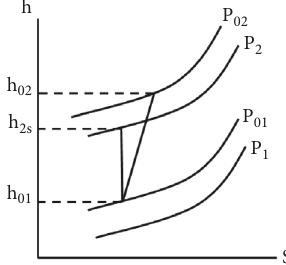
Figure2:Idealandrealisticcompressionprocessinsidecompressor.